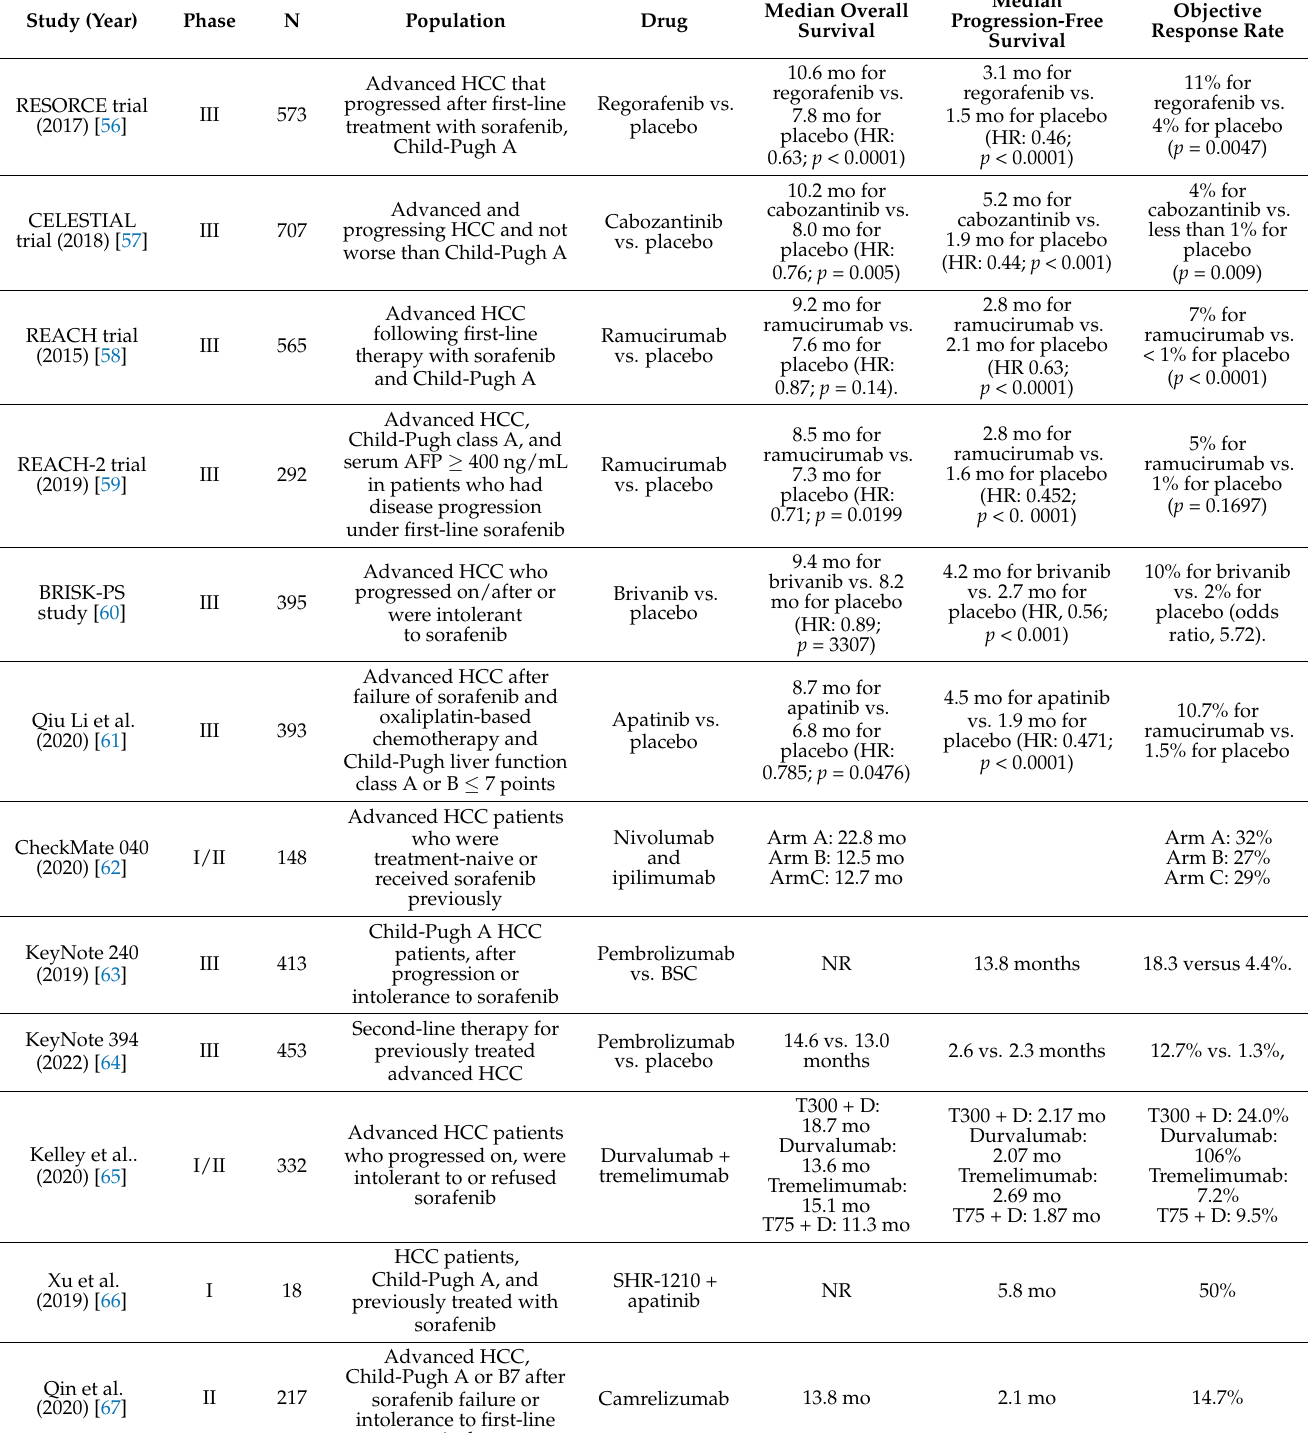
Table 2. Results of selected trials in second-line and beyond for patients with advanced